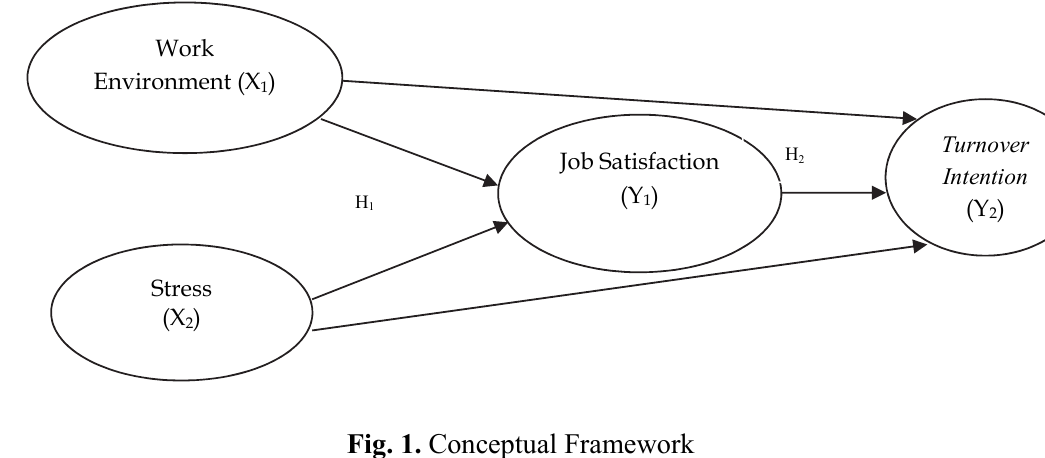
Fig. 1. Conceptual